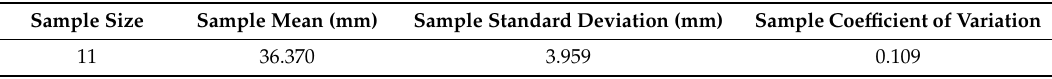
Table 5. Sample statistical data of the compression length of the aluminum honeycomb.